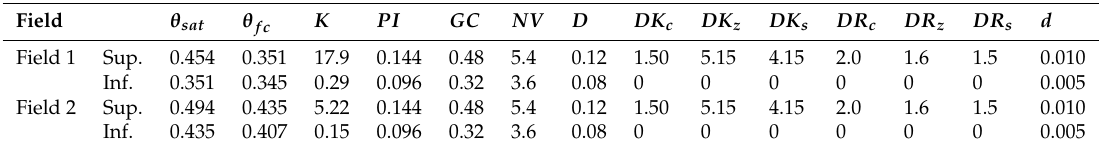
Table 2. Range of unmeasured parameters for sensitivity analysis.